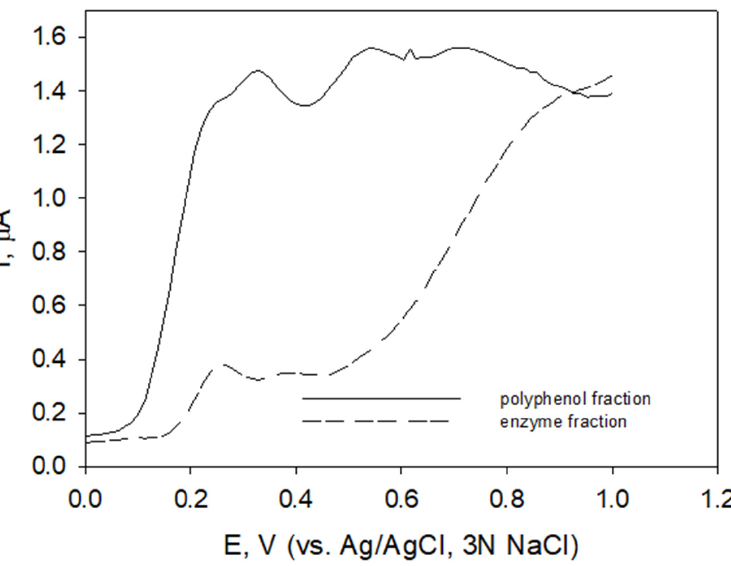
Figure 3. Differential pulse voltammograms of carbon paste electrode in polyphenolic fraction FB (solid line) and enzyme fraction FA (dashed line) of R. idaeus bark extract, phosphate buffer pH 6.0; potential step 4 mV, pulse width 50 ms, pulse period 200 ms, pulse amplitude 50 mV.